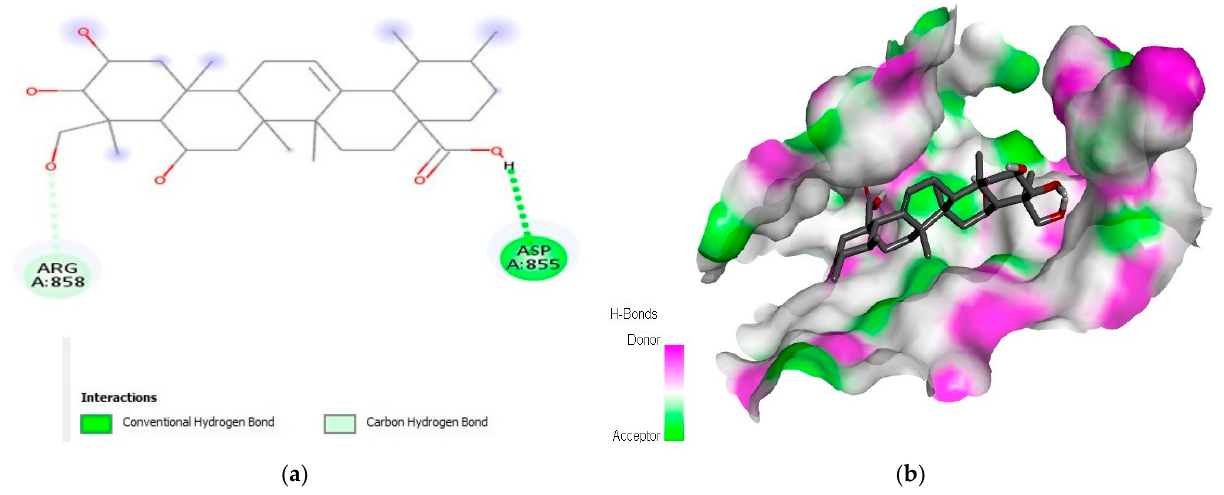
Figure 2. Interaction ( a ) and binding pattern ( b ) of madecassic acid with EGFR as a receptor.